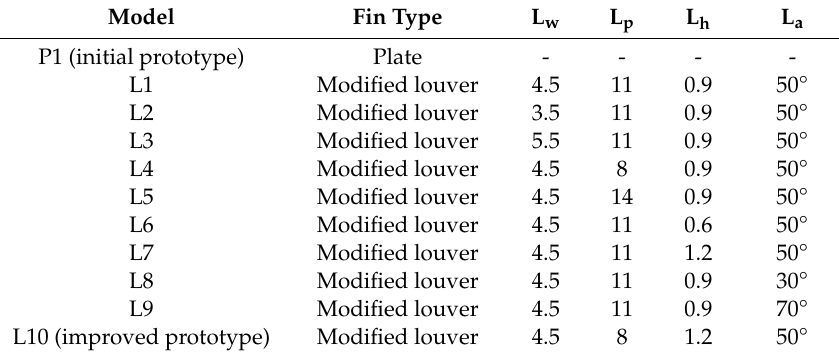
Figure 4. Simulation model with boundary conditions: ( a ) Physical fin design; ( b ) simulation domain. Table 3. Specifications of the physical model.